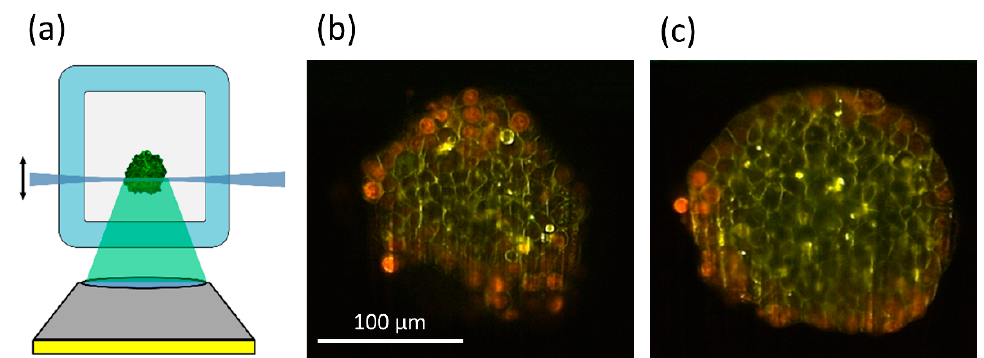
Figure 6. Principle of light sheet microscopy ( a ); image sections of MCF-7 spheroids incubated for 6 h with doxorubicin (8 µM) at a depth of 20 µm ( b ) or 60 µm ( c ) within the spheroid. Red and green- yellow fluorescence permit distinction of doxorubicin and its degradation product. Reproduced from [57] with modifications.